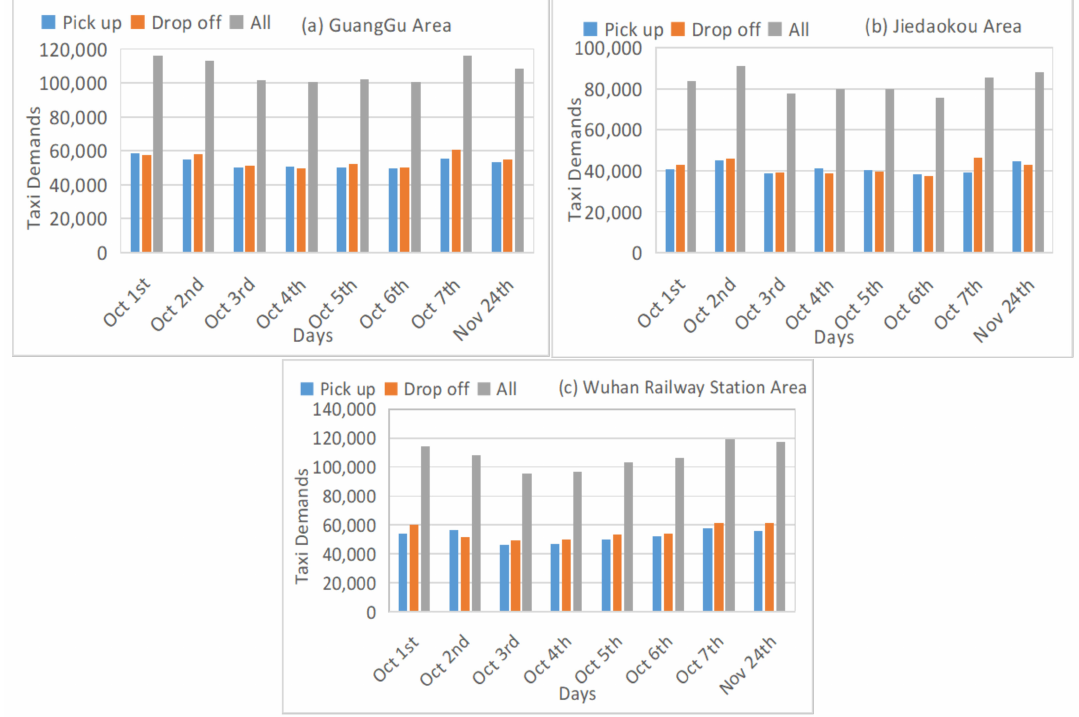
Figure 7. Taxi demands distribution in the city of Wuhan during holidays. Holidays show high taxi demands in the three